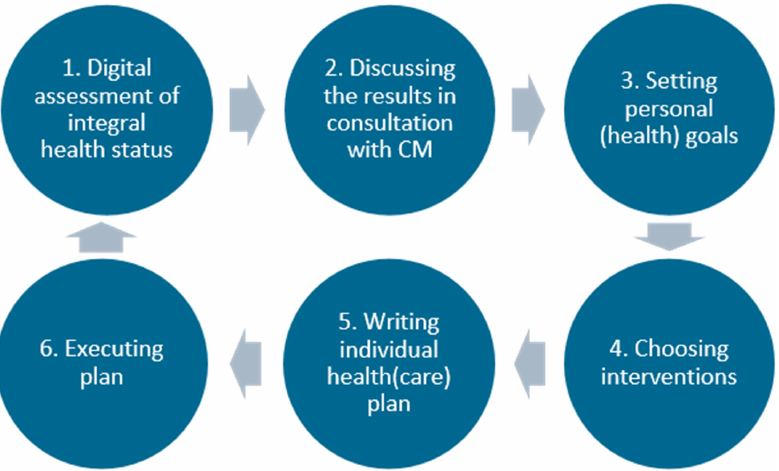
Figure 2. Conceptual model for PC-IC for patients with (multiple) chronic conditions in primary care. In the Dutch primary care setting, the PN in the general practice was recommended to serve